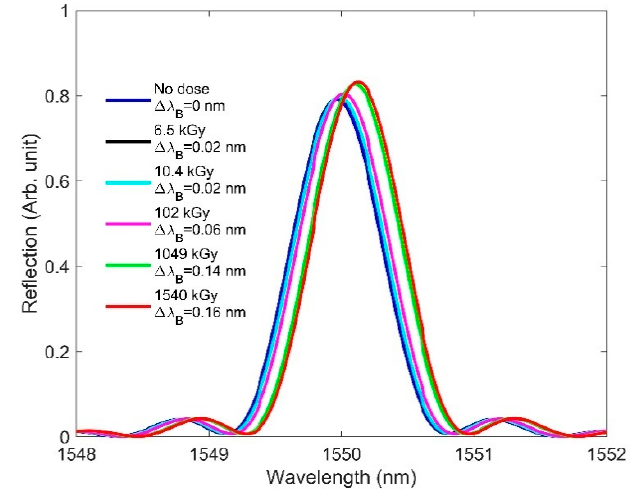
Figure 4. RIC effects on FBG: redshift in the Bragg wavelength from 1550 to 1550.16 nm as the dose is increased from 0 to 1540 kGy, where ∆𝜆 (cid:3003) denotes the Bragg wavelength shift.